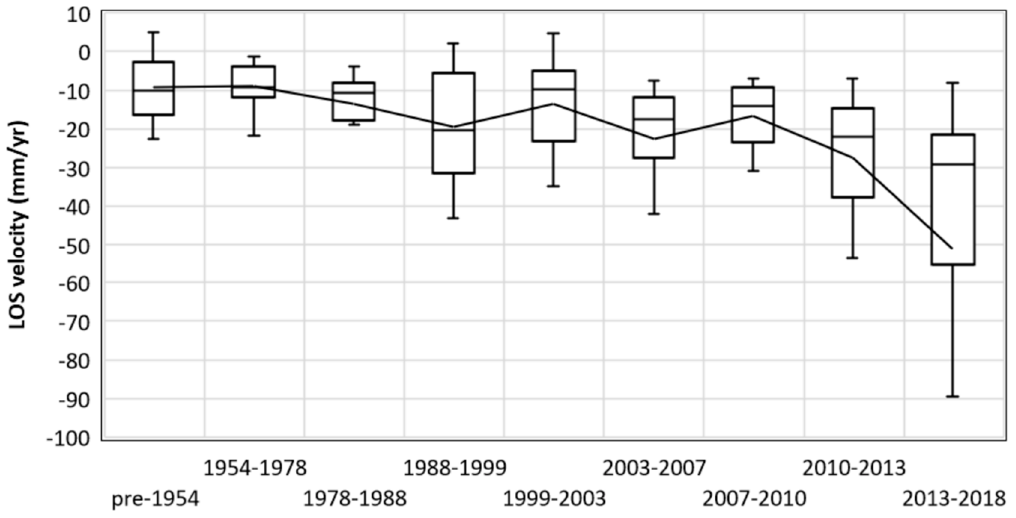
Figure 9. Box plot showing the variability of the velocity values depending on the time of formation of the sinkholes in the mining concession around Saline di Volterra. The solid line represents the mean value, the stroke within each box plot the median value.